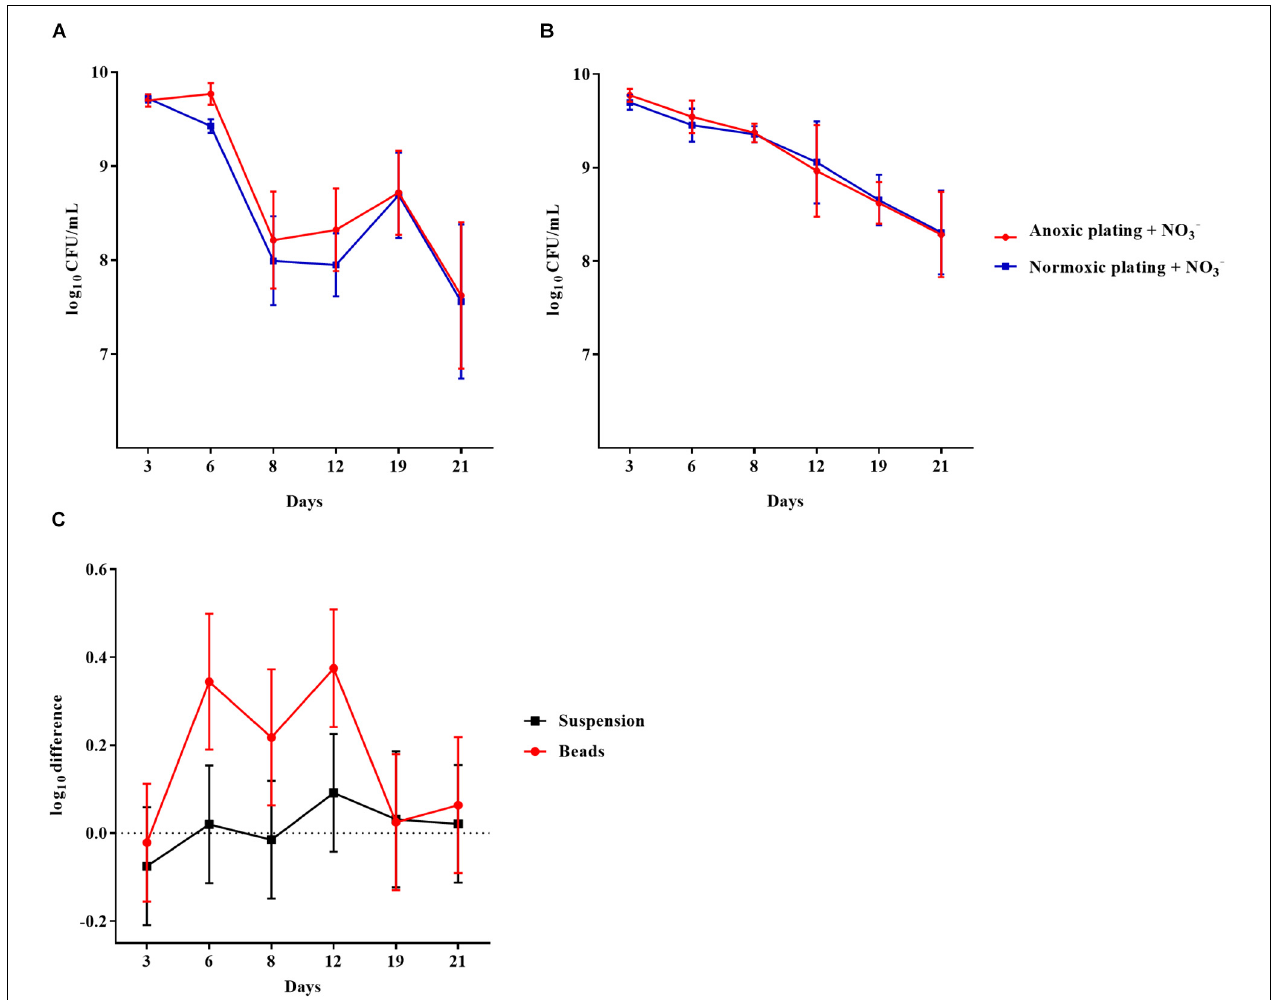
FIGURE 2 | An oxygen intolerant subpopulation of Pseudomonas aeruginosa (PAO1) was generated in the bead biofilm model. Normoxic and anoxic colony forming units per milliliter (CFU/mL) of PAO1 over 21 days from the beads (A) and the surrounding suspension (B) . Symbols with error bars indicate the mean ± SEM ( n = 4). + NO 3 - refers to the addition of 10 mM KNO 3 to LB agar plates. The log difference (C) represents the difference in mean log CFU/mL between plating methods from the suspension and the beads, respectively. The log difference was significantly higher ( p = 0.003, linear regression) in the beads than the surrounding suspension. Symbols with error bars indicate the mean + confidence